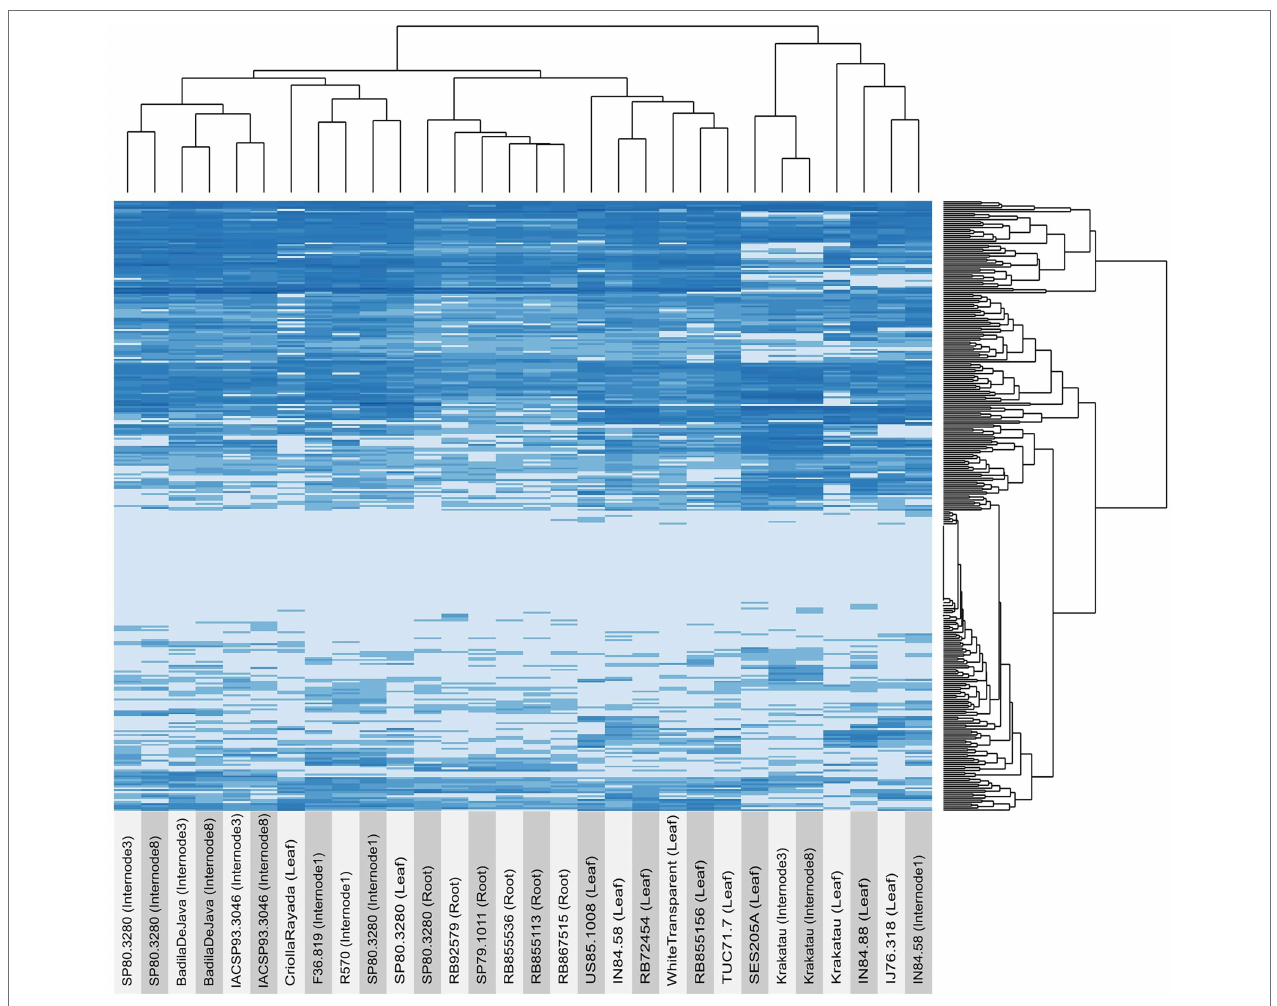
FIGURE 2 | Expression profiles of orphan genes (OGs) in several sugarcane tissues and genotypes. The expression of each gene (TPM) was estimated using a pseudoalignment method implemented in Salmon